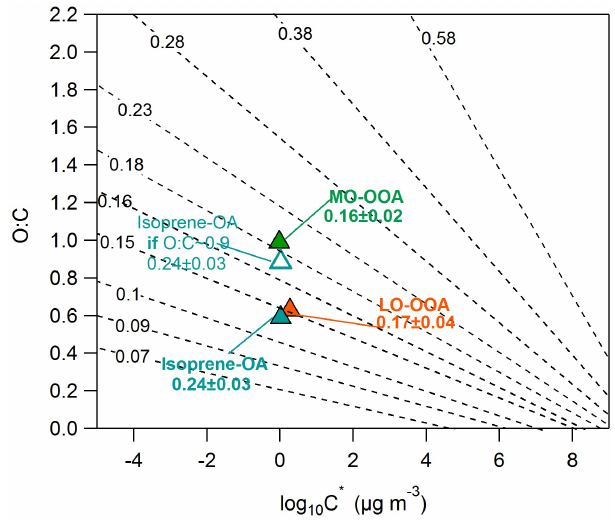
Figure 6. O : C ratios versus the average volatility as log 10 C ∗ . The black isolines correspond to the theoretically intrinsic κ suggested by Nakao (2017). The triangles denote the SOAS PMF factors. The hygroscopicity of the SOAS PMF factors has been transformed into the intrinsic κ , using the water solubility results of Xu et al. (2017). The open cyan triangle corresponds to the isoprene-OA with a hy- pothetical O : C =